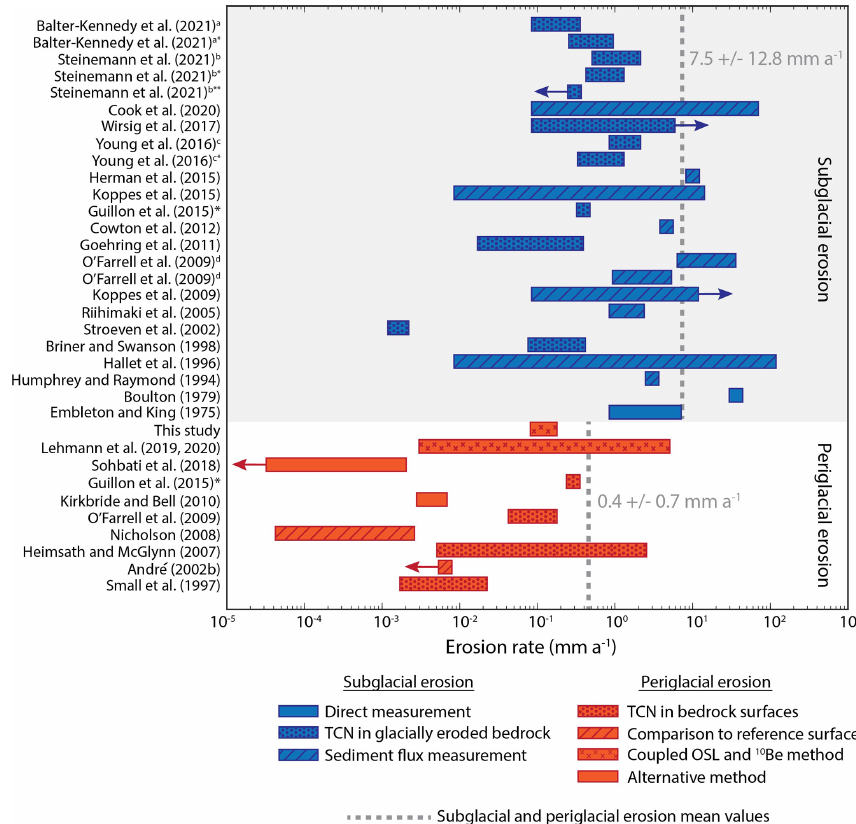
Figure 6. Summary of the results of studies worldwide which have attempted to calculate subglacial erosion rates (blue) and periglacial erosion rates (red). Results involving bedrock of sedimentary lithology were excluded as they are not comparable with our study area. The arrows signify “greater than” or “less than”. The grey dashed lines are the mean subglacial and periglacial erosion rates, accompanied by ∗ the respective mean and standard deviation values. a Centennial timescale using 10 Be of surficial bedrock surfaces and a orbital timescale ∗ 10 using 10 Be depth profiles in a bedrock core. b Measured at marginal locations using 10 Be and 14 C and at riegel formations using b Be ∗∗ 14 ∗ calculated an approximate basin-wide erosion rate (incorporating both and b C. c Measured on abraded bedrock using 10 Be and then c abrasion and quarrying). d Reported results from two separate glaciers. ∗ Guillon et al. (2015) applied a TCN technique but in sediment flux measurements, as opposed to